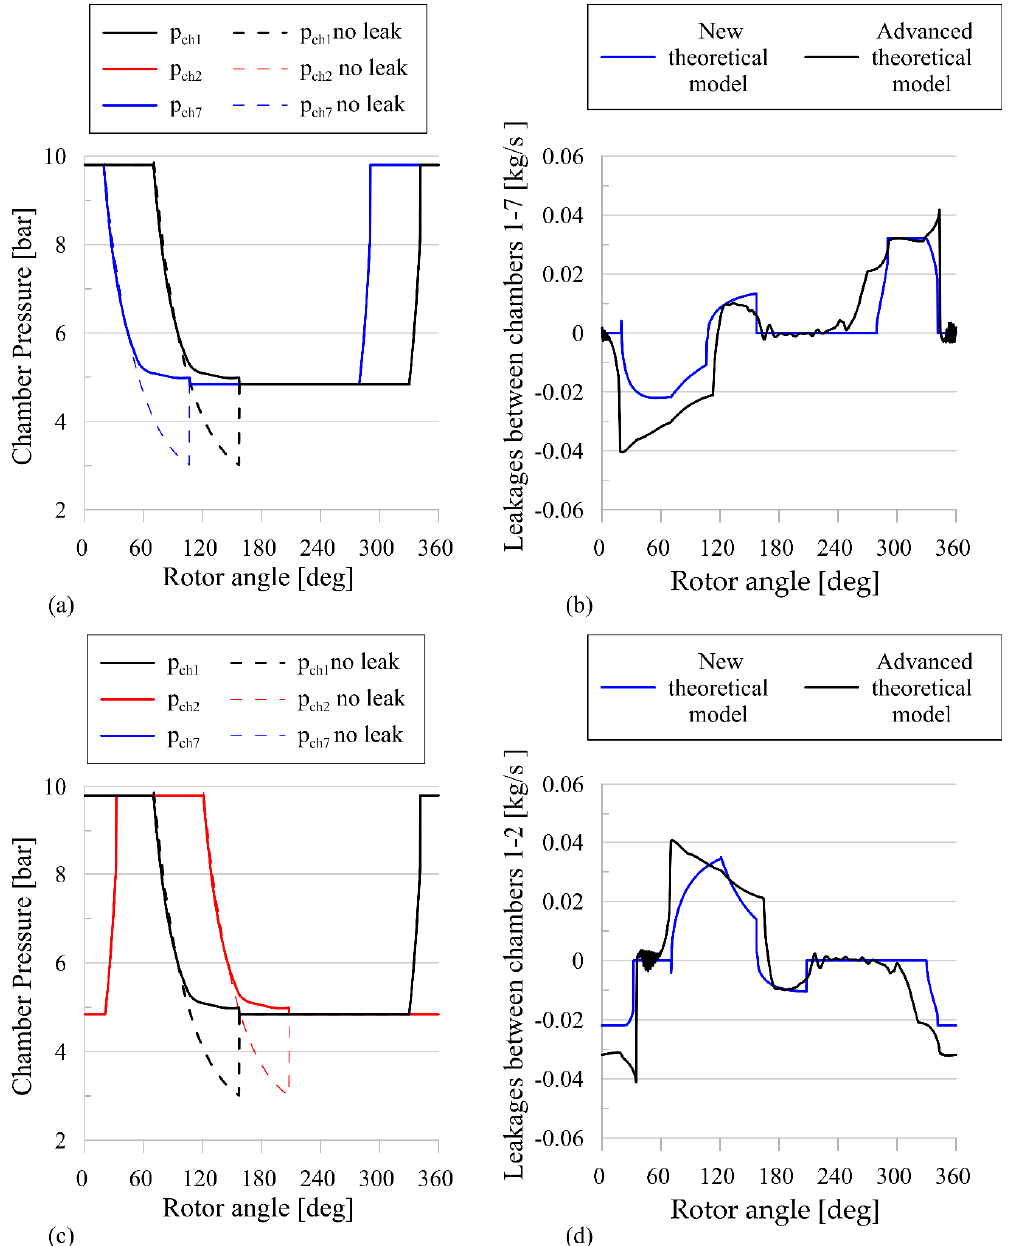
Figure 2. Pressure profile angle phasing between chamber 1 and chamber 7 (previous in the sense of rotation) ( a ) and corresponding leakages at tip blade ( b ); Pressure profile angle phasing between chamber 1 and chamber 2 (next in the sense of rotation) ( c ) and corresponding leakages at tip blade ( d ).